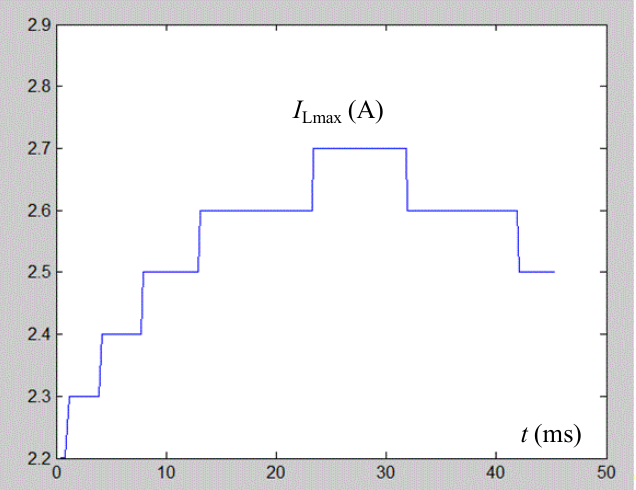
parameter during the energy Lmax